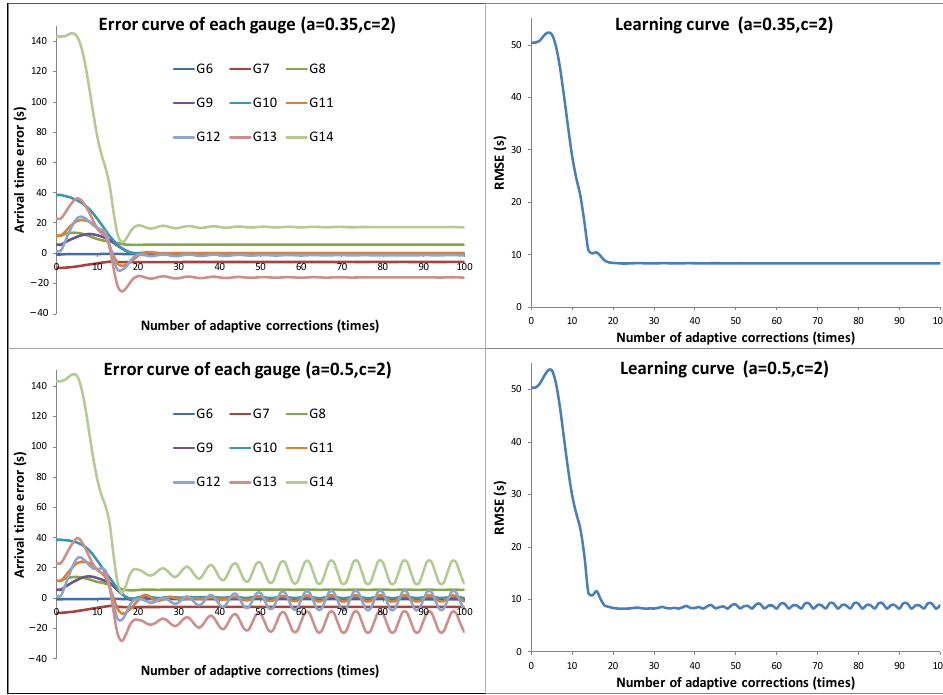
Figure 14. Error curve and learning curve of each gauge in logic-B ( c = 2, a = 0.35 or